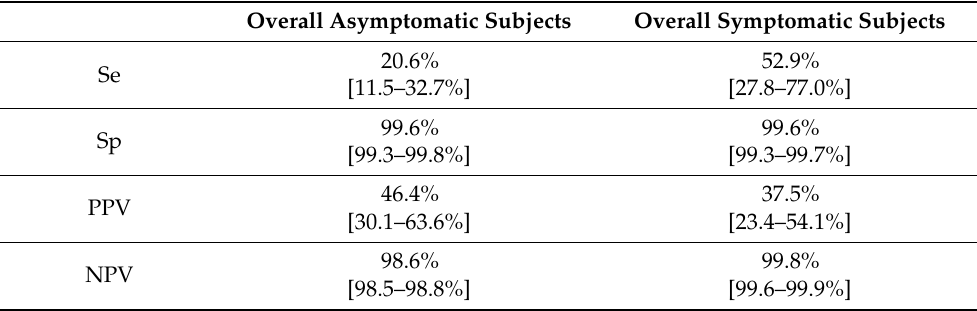
Table A2. Overall performance of the RAT for asymptomatic and symptomatic subjects.